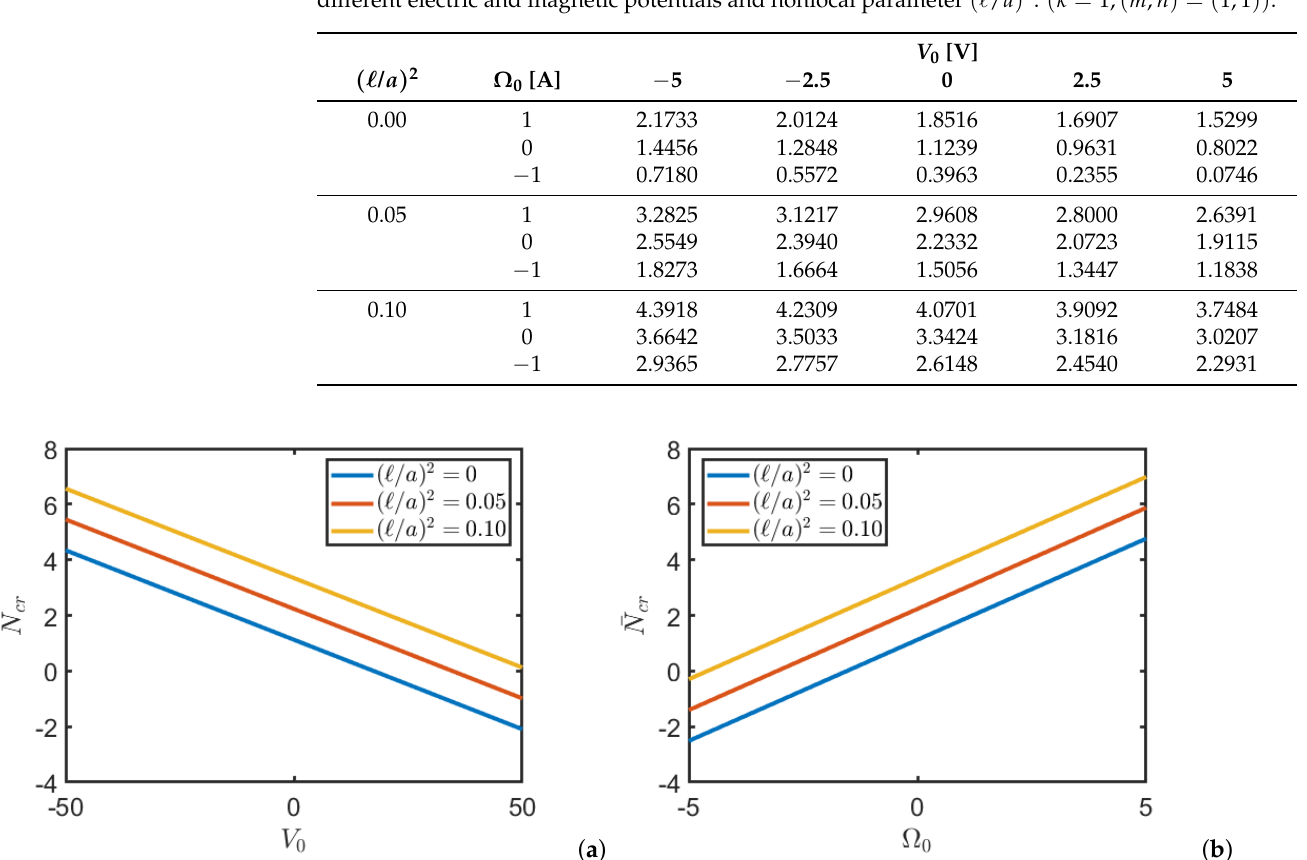
Table 2. Dimensionless critical load ¯ N cr of a square FG plate composed of BaTiO 3 /CoFe 2 O 4 for different electric and magnetic potentials and nonlocal parameter ( (cid:96) / a ) 2 . ( κ = 1, ( m , n ) = ( 1,1 )) .